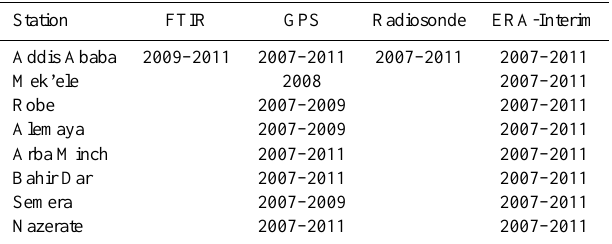
Table 3. The ground-based GPS receivers used in this study and their